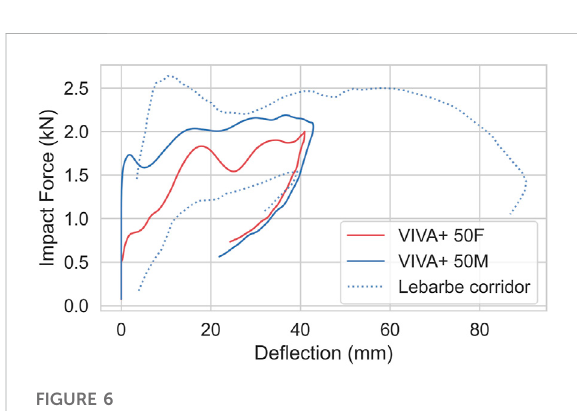
FIGURE 6 Blunt thorax impact simulations, compared to 4.3 m/s average male corridors from Lebarbé and Petit, 2012.